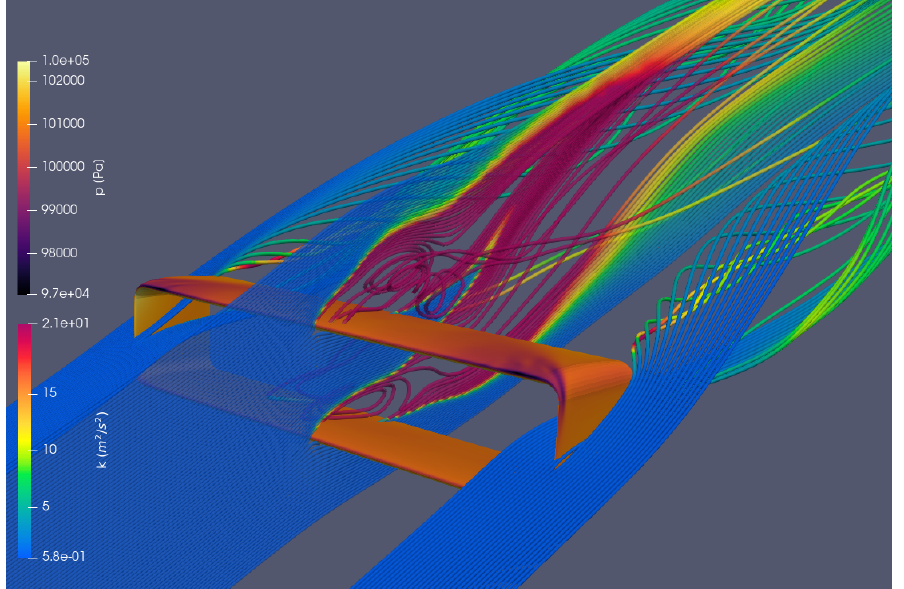
Figure 11. Pressure distribution on a box wing, the magnitude of the turbulent kinetic energy, and streamlines starting in the symmetry planes; the angle of attack of the wing is 21 ◦ , and the flow speed is 36.65 ms − 1